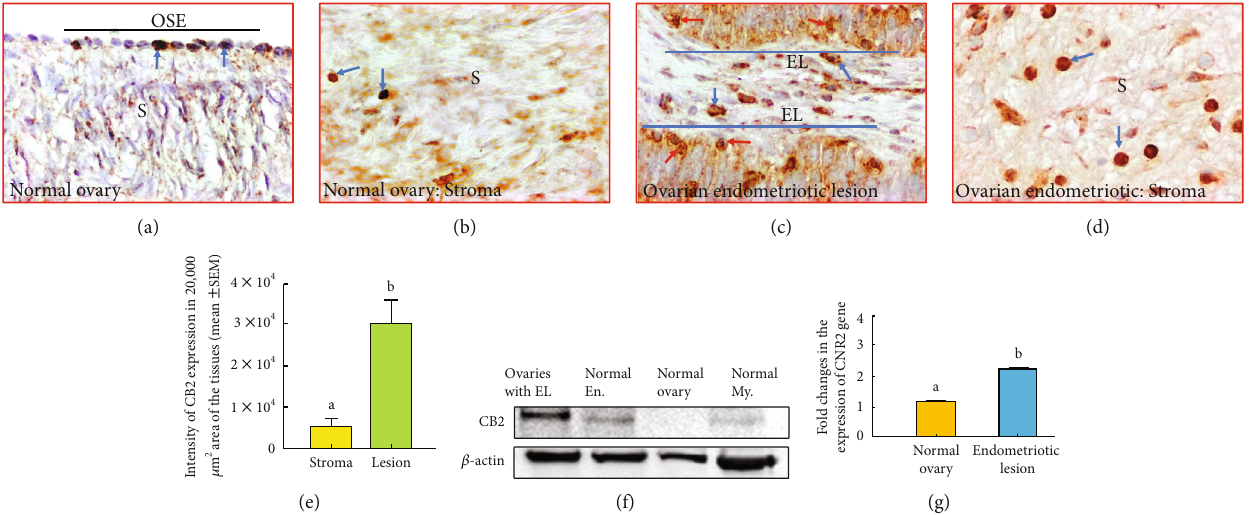
Figure 5: Expression of cannabinoid receptor 2 (CB2) by the epithelial cells or stromal cells in ovaries with or without endometriosis. (a) Section of a normal ovary showing occasional staining by a few epithelial cells of the ovarian surface. (b) Section of a normal ovary showing CB2 staining by a few immune cell-like cells in the stroma (S). (c) Section of an ovary with endometriosis showing CB2 expression by the cell membrane and nuclei of the epithelial cells in endometriotic lesions (EL). Interlesion stromal cells also showed staining for CB2. (d) Section of an ovary with endometriosis showing CB2 expression by many immune cell-like cells in the stroma. (e) Intensity of the CB2 expression was signi fi cantly higher in the epithelial layers in endometriotic lesions than the stroma in ovaries with endometriosis ( P < 0 : 05 ). (f) CB2 protein expression: immunoblotting detected CB2 protein of approximately 40 kDa in tissue extracts from ovaries with endometriosis, normal endometrial, and myometrial tissue extracts. Extracts from normal ovaries showed no or very weak expression for CB2. In contrast, ovaries with endometriosis showed strong signal for CB2. (g) Gene expression studies detected strong expression for CNR2 gene in ovaries with endometriosis, while it was almost undetectable in normal ovarian tissues. EL =endometriotic lesions; OSE=ovarian surface epithelial cells; Normal En=normal endometrium; Normal My =normal myometrium; S =stroma; 40x =magni fi cation. Arrows indicate examples of immunopositive CB2 cells in the normal OSE cells and immune cell-like stromal cells (blue arrows) and nuclei (red arrows) of the endometriotic cells. Bars with di ff erent letters denote signi fi cant di ff erence between